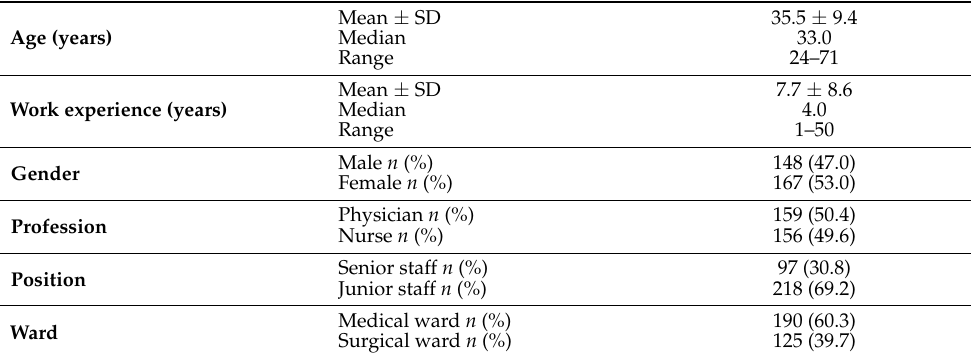
Table 1. Demographic characteristics of the participants ( n = 315).